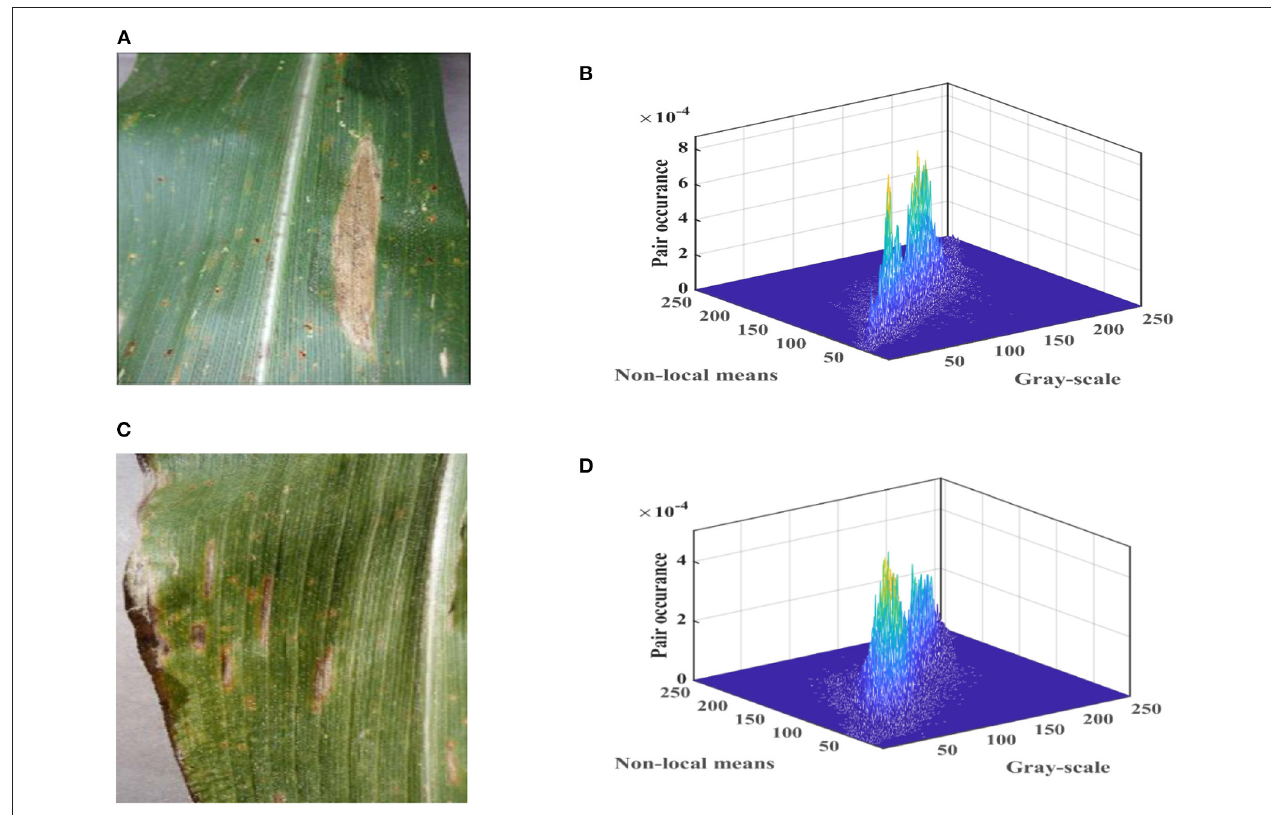
FIGURE 2 | Color images and three-dimensional (3D) views of two-dimensional (2D) histograms for maize leaf spot disease and maize gray spot disease in the Plant Village.